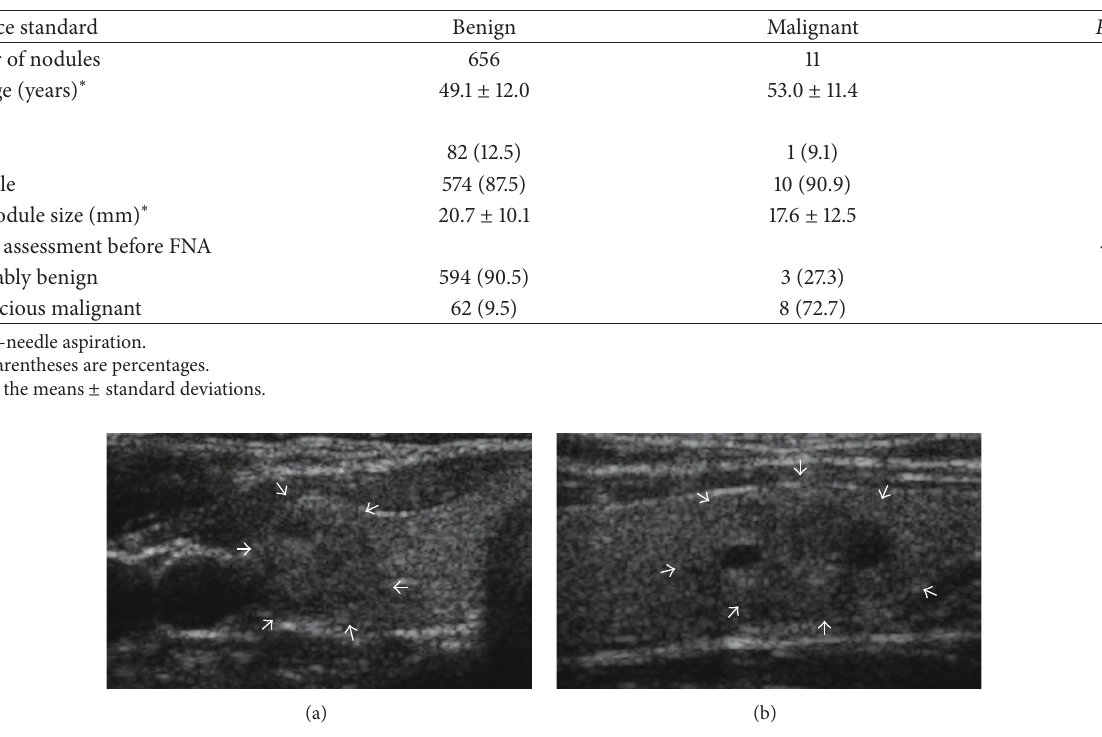
Table 1: Baseline characteristics of 667 thyroid nodules with benign cytology.